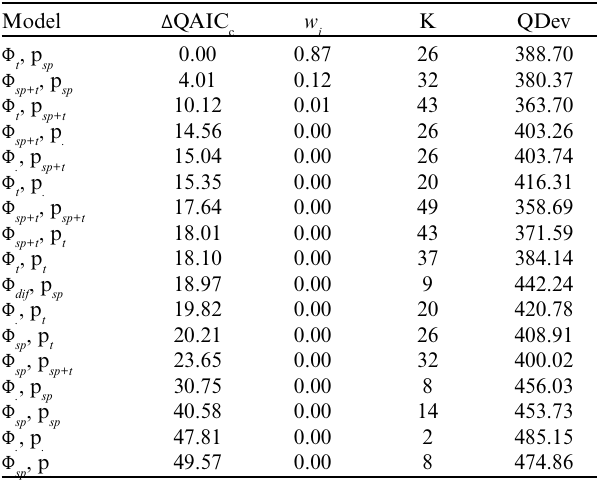
Table 2 . Model selection statistics for after-hatch-year male Golden-cheeked Warbler ( Setophaga chrysoparia )